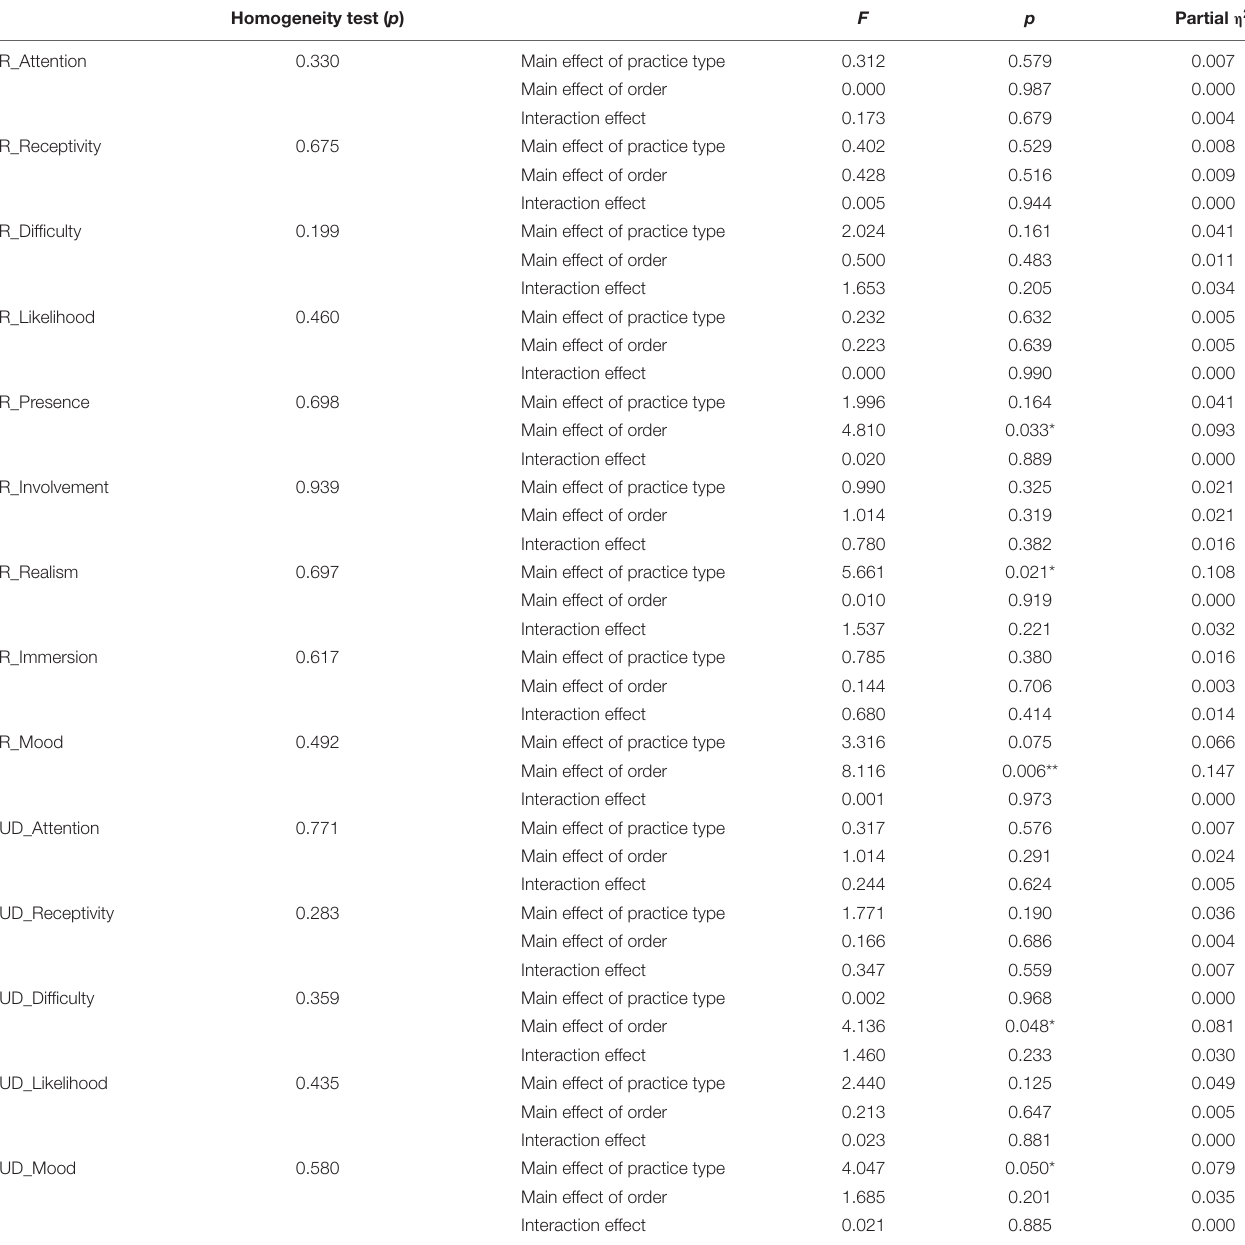
TABLE 2 | Results of two-way between-subjects ANOVA